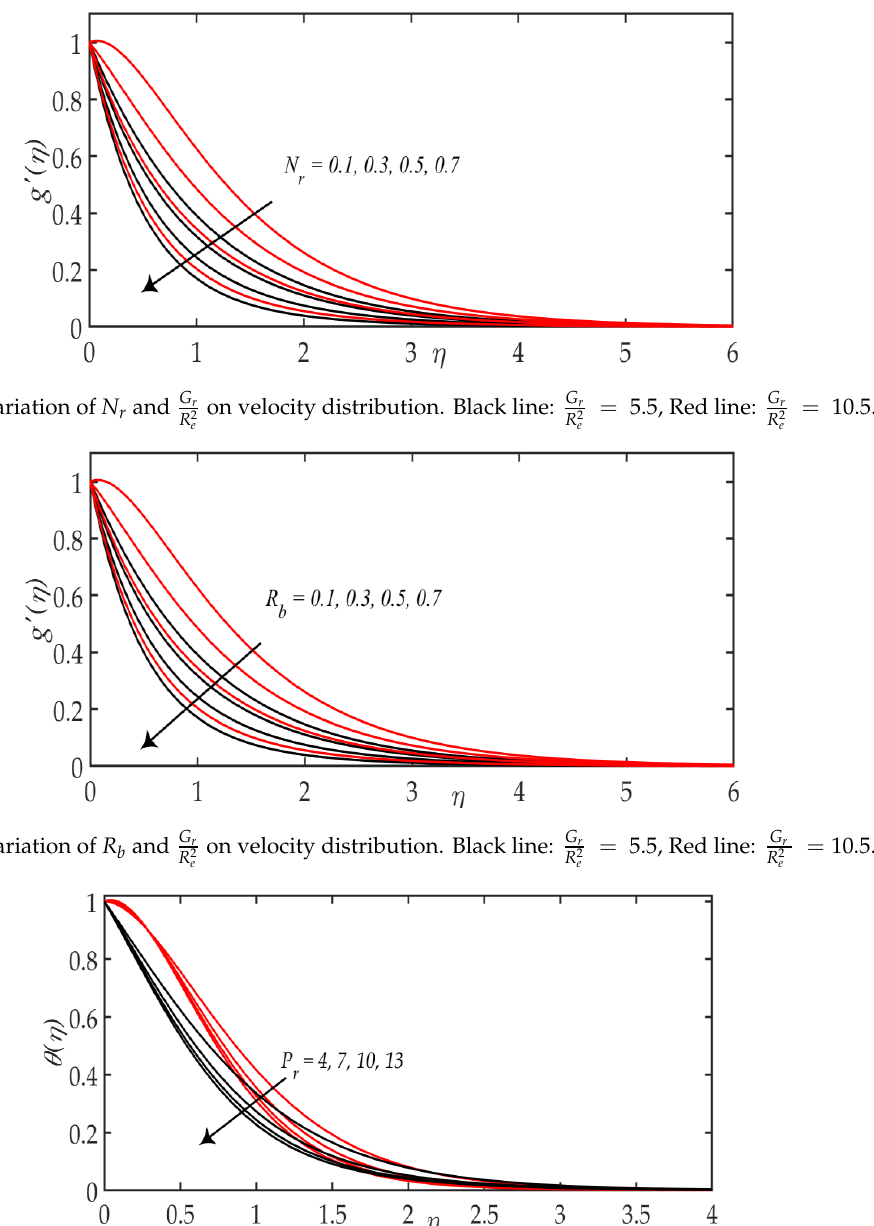
Figure 2. Variation of 𝛽 𝐷 and 𝑀 on velocity distribution. Black line: 𝑀 = 0 , Red line: 𝑀 = 3.